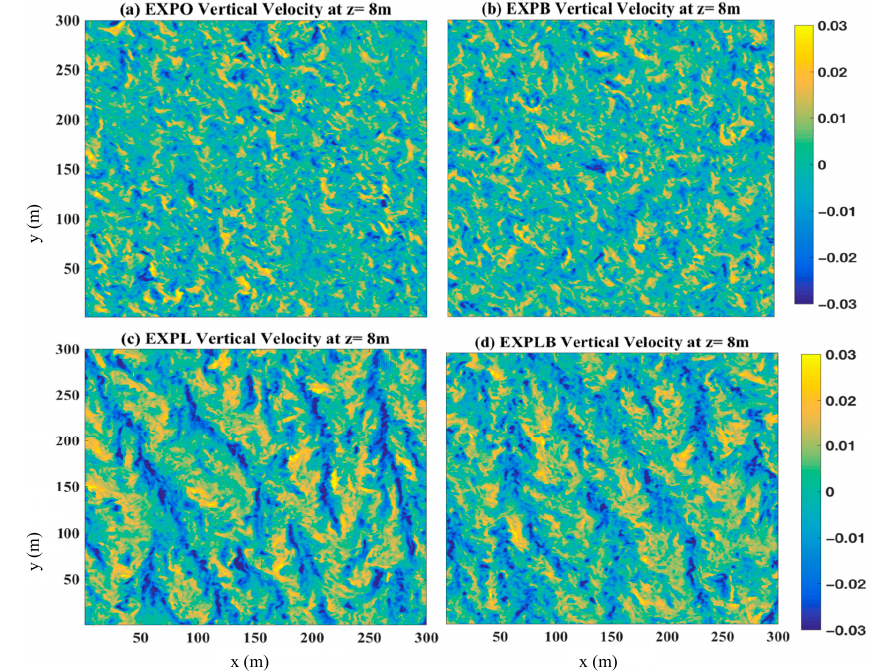
Figure 2. Horizontal cross-section of vertical velocity (m/s) (z = 8 m) without LC and BW ( a ); with only BW ( b ), with only LC ( c ); with LC and BW ( d ).